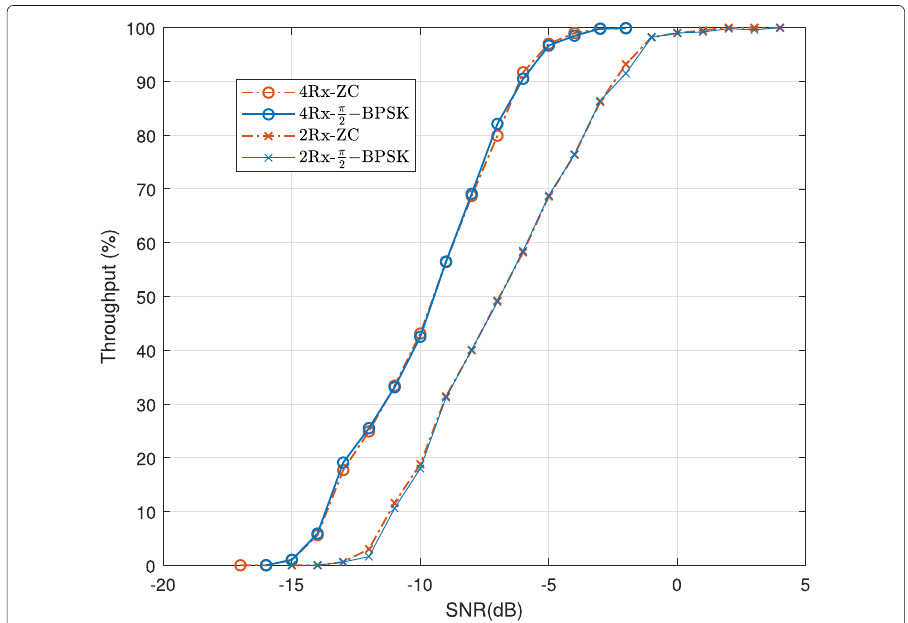
Fig. 19 Throughput comparison for the length-96 DMRS